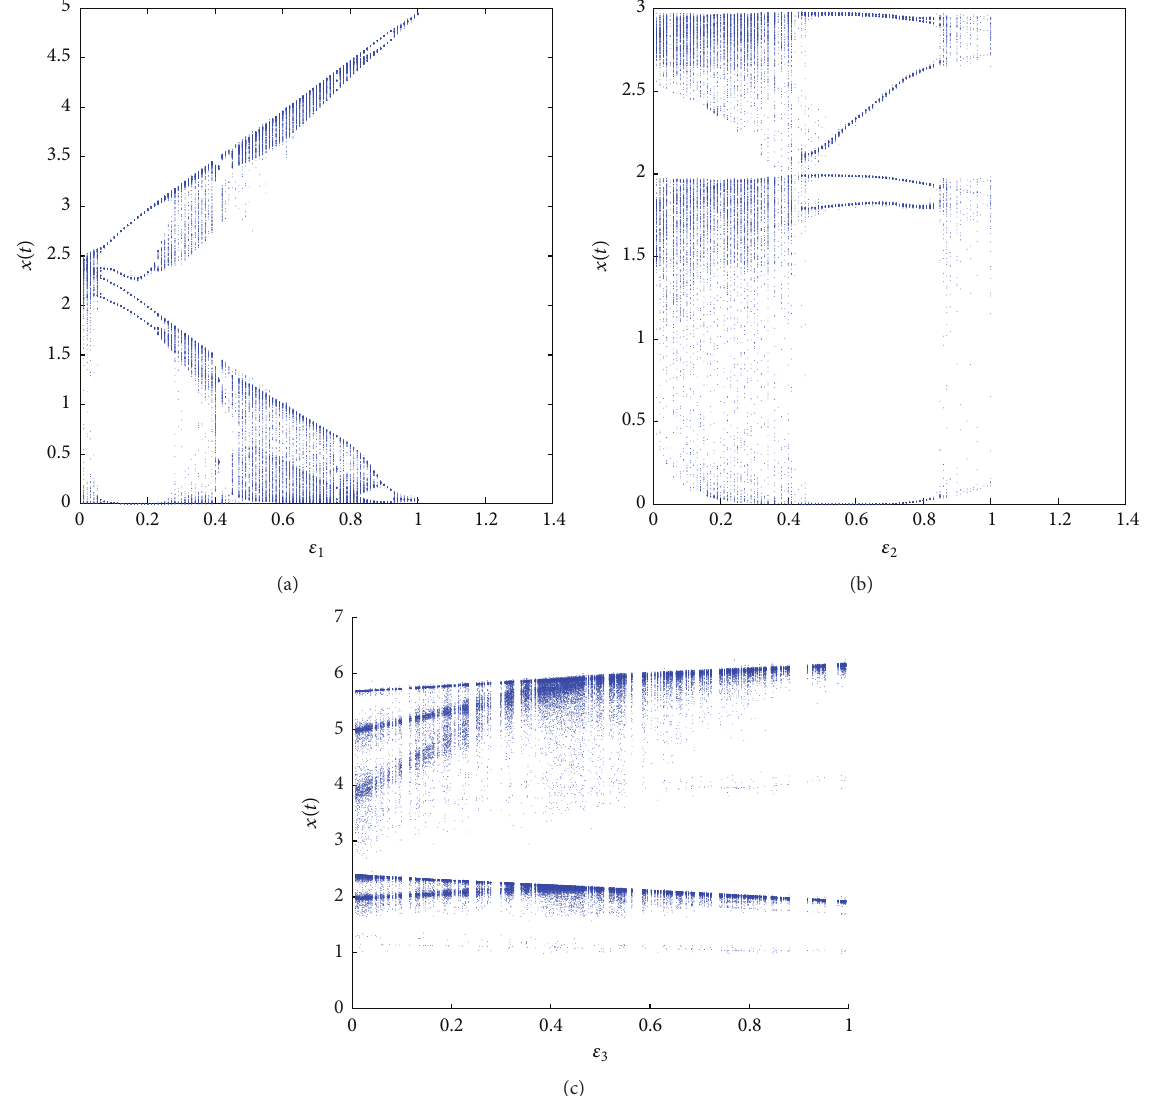
Figure 6: (a) Bifurcation diagram of system (1) with Holling type IV functional responses with respect to seasonal parameters (a) 𝜀 1 , (b) 𝜀 2 , and (c) 𝜀 3 with data set